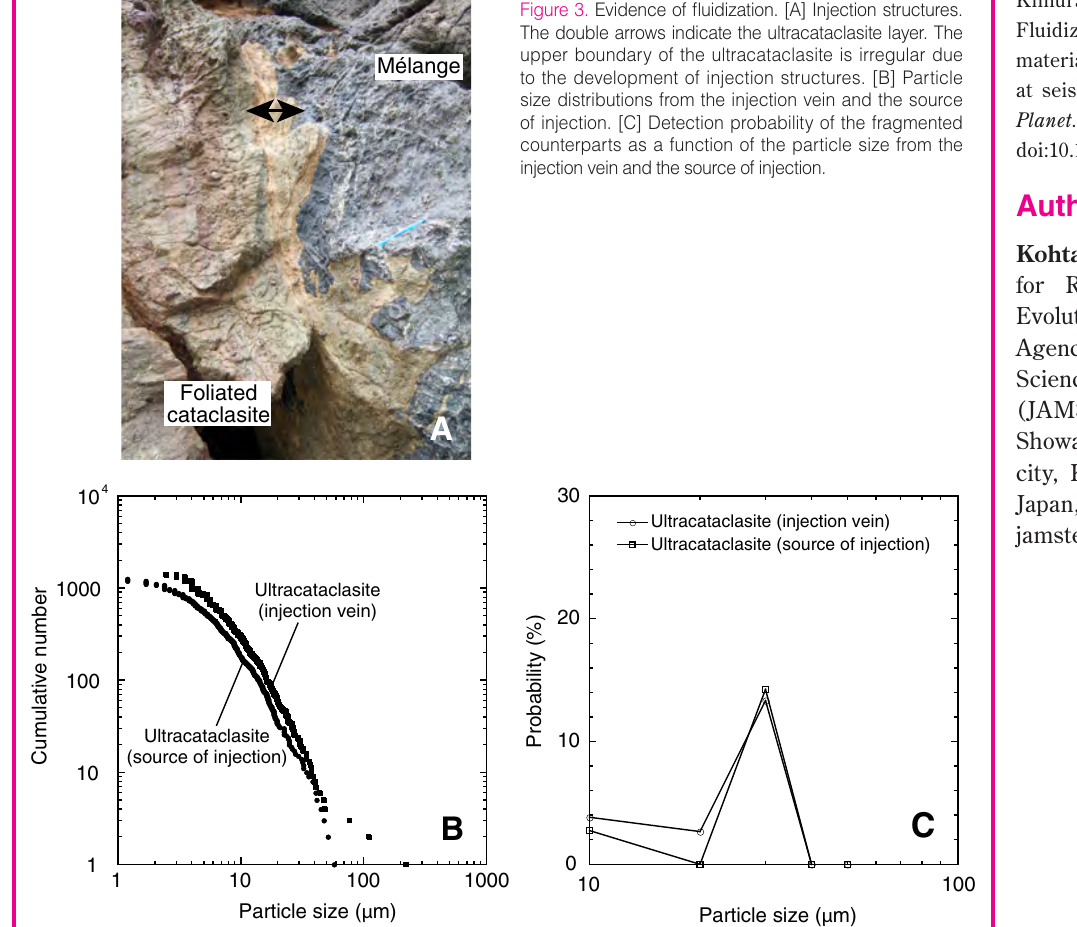
hydraulic fracturing normal to the least principal stress.